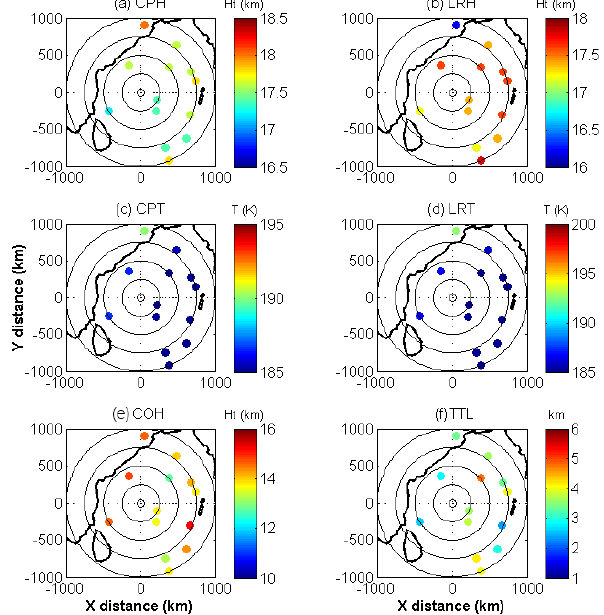
Figure 3. Spatial variation of (a) CPH, (b) LRH, (c) CPT, (d) LRT, (e) COH, and (f) TTL thickness with respect to the centre of cyclone Nargis observed on 28 April 2008 for the RO shown in (b) . Black circles are drawn to show the 250, 500, 750, and 1000km distance away from TC